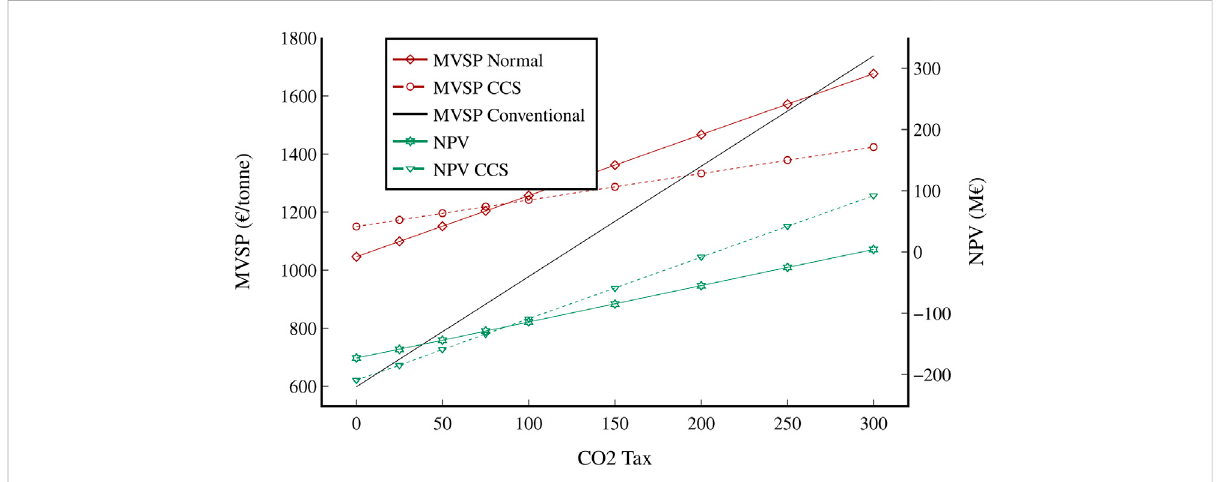
FIGURE 13 Change in MVSP and NPV for both scenarios and the conventional benchmark with respect to the CO 2 emissions tax. All other variables remained constant. The median value of the conventional benchmark was used (2021